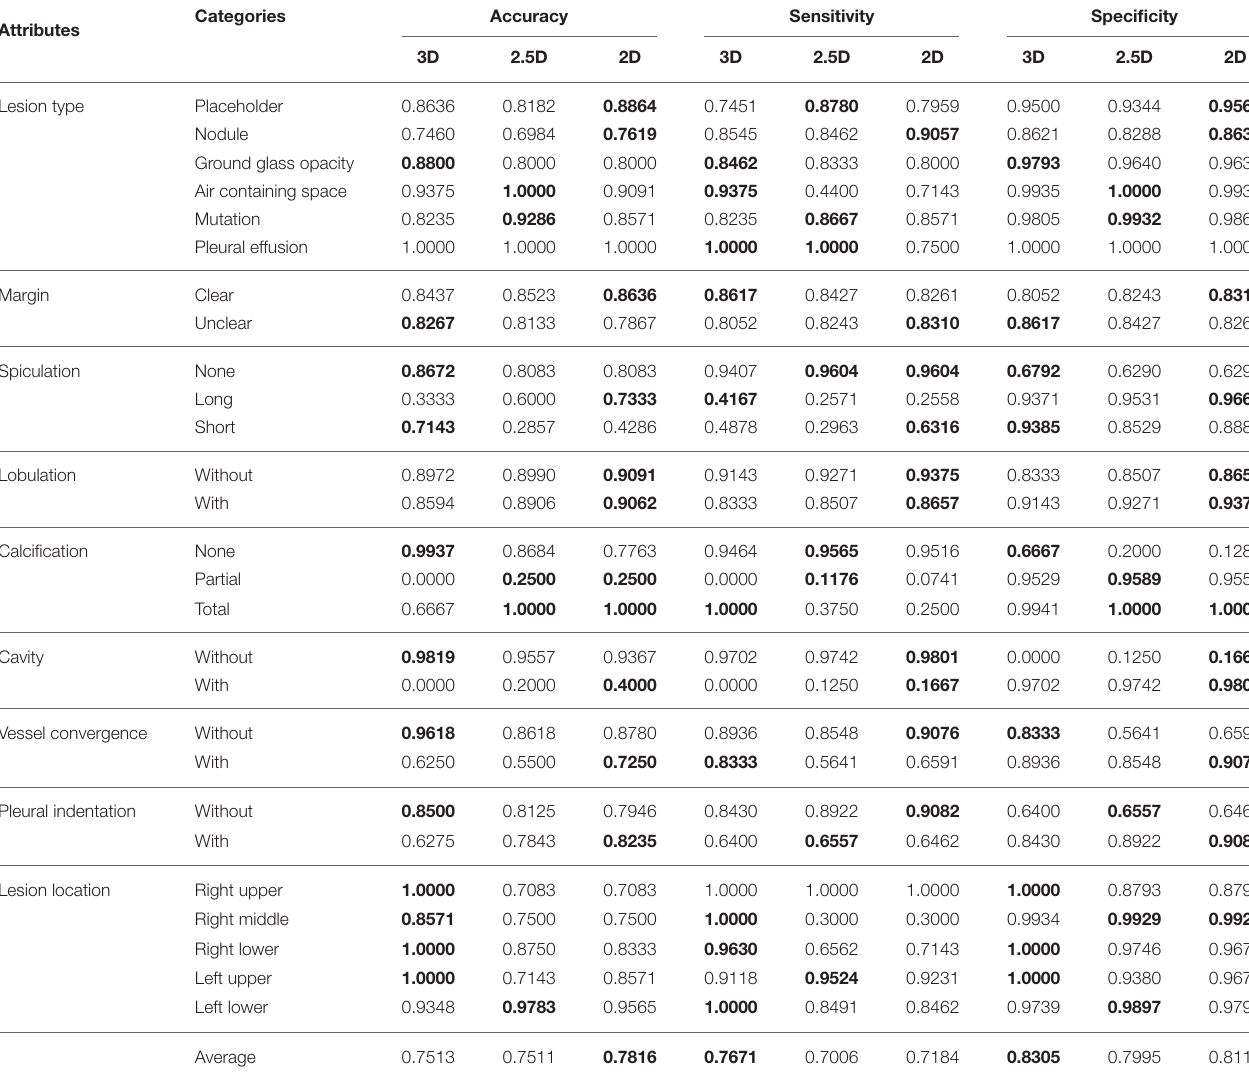
TABLE 3 | Performance of the basic model on the 3D, 2.5D, and 2D